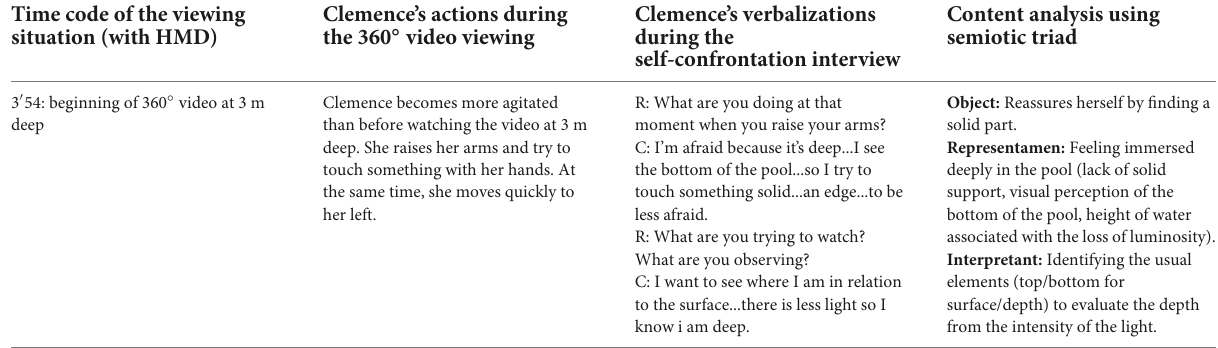
TABLE 1 Example of data analysis. Time code of the viewing situation (with